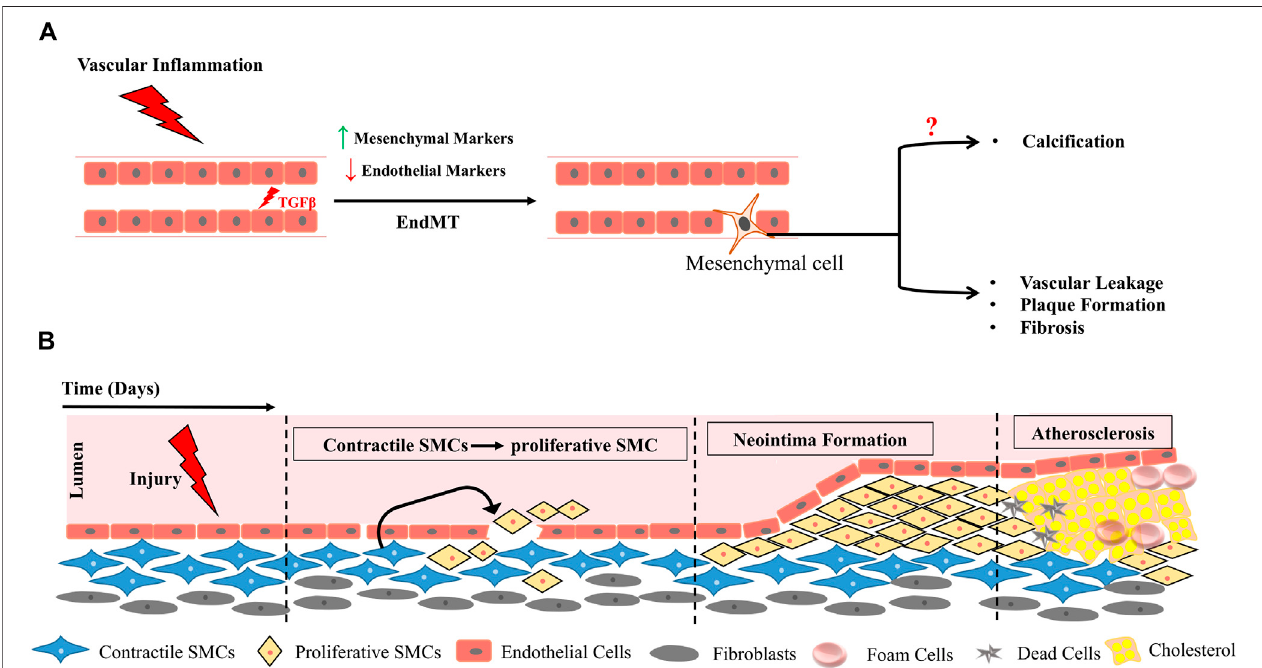
FIGURE 6 | Vascular In fl ammation triggers EndMT (A) , functional plasticity changes in smooth muscle cells (SMCs) and results in formation of neo-intima precipitating plaque deposition (B) .